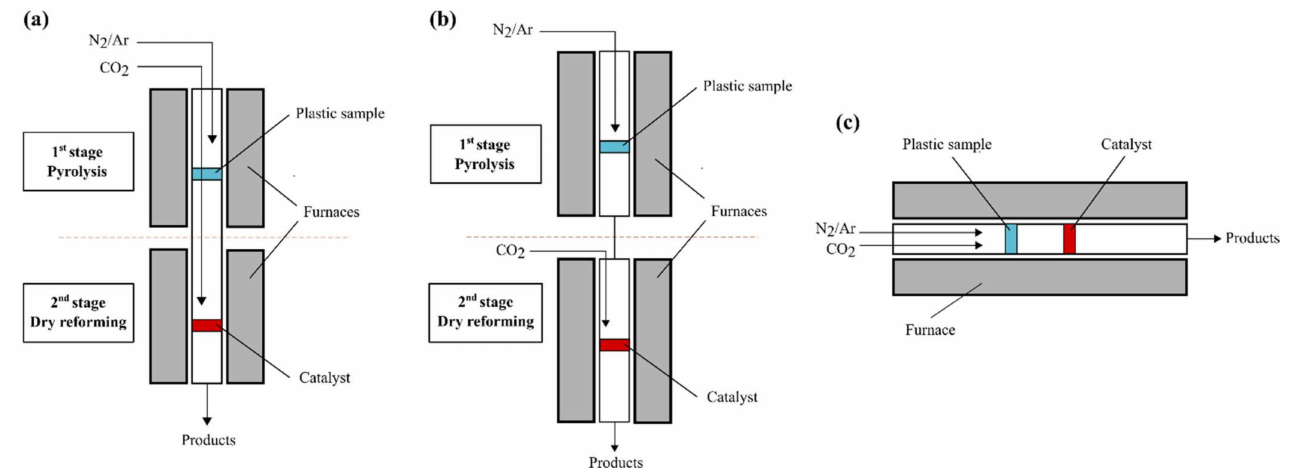
Figure 2. Different reactor configurations used in the laboratory scale pyrolysis-catalytic dry reform- ing process: ( a ) Two-stage reactor; ( b ) Two-stage reactor system consisting of two separate reactors; ( c ) One-stage reactor.